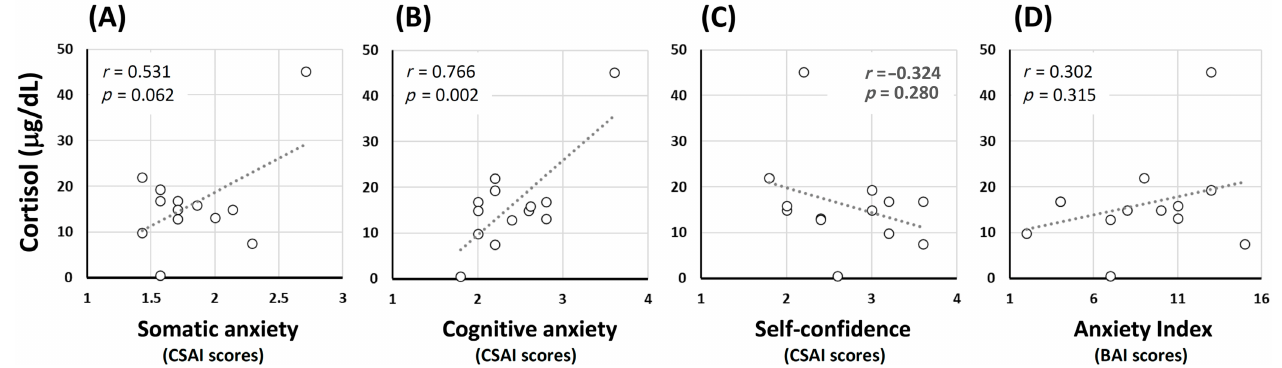
Figure 2. Linear correlation between cortisol levels and ( A ) somatic anxiety; ( B ) cognitive anxiety; or ( C ) self-confidence CSAI scores; and ( D ) anxiety BAI scores of novice jiu-jitsu athletes in their first official competitions (N =